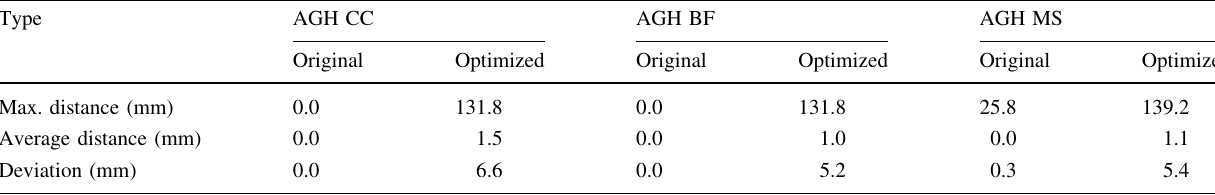
Table 2 Deviation of original point cloud and the AGH meshes